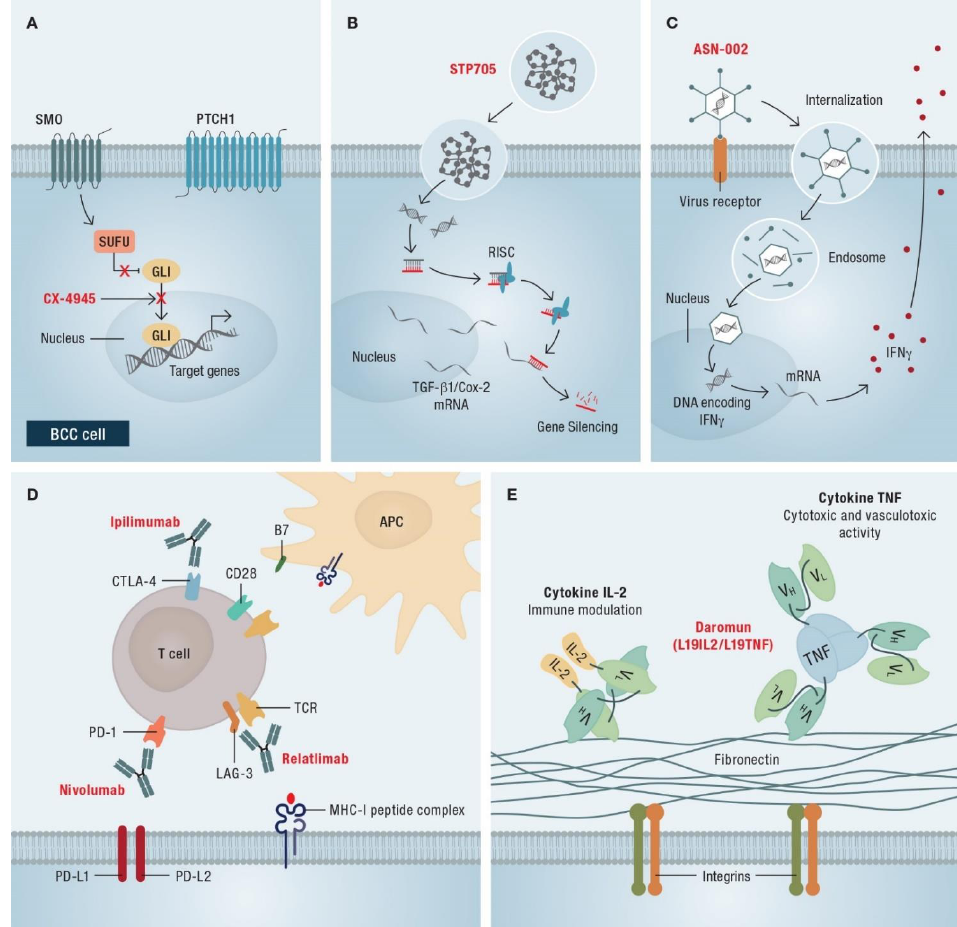
Figure 5. Schematic representation of the modes of action of novel drugs for basal cell carcinoma (BCC) therapy. ( A ) Loss-of-function mutations in PTCH1 or activating mutations in SMO activate the HH signaling pathway in BCC cells. CX-4945 acts on the terminal HH signaling components by inhibiting casein kinase CK2. Thus, the signal transduction pathway is interrupted; ( B ) STP705 consists of two small interfering RNA (siRNA) oligonucleotides packaged with a histidine-lysine (HK) polymer as a delivery system. The siRNA intermediates bind to an RNA-induced silencing complex (RISC), and then selectively degrade the complementary single-stranded target RNA. As the siRNA of STP705 targets the mRNA of transforming growth factor (TGF)- β 1 and cyclooxygenase (Cox)-2, respectively, it downregulates the expression of TGF- β 1 and COX-2, resulting in tumor growth inhibition; ( C ) ASN-002 functions as a recombinant adenovirus vector, delivering the human interferon (IFN)- γ gene into BCC cells. IFN- γ secretion results in a local IFN- γ concentration within the tumor; ( D ) the checkpoint inhibitor nivolumab blocks binding of programmed cell death protein 1 (PD-1) on T cells to its ligands programmed cell death 1 ligand 1 (PD-L1) and PD-L2 on tumor cells. Relatlimab is an antibody directed against the inhibitory molecule lymphocyte-activation gene (LAG)- 3. Binding of cytotoxic T-lymphocyte-associated protein (CTLA)-4 to the B7 molecules as antagonist of CD28 on antigen-presenting cells (APCs) is blocked by ipilimumab. These checkpoint inhibitors may release the T cells from immunosuppressive mechanisms of the tumor microenvironment; ( E ) Daromun (L19IL2/L19TNF) consist of recombinant interleukin (IL)-2 and tumor necrosis factor (TNF)- α cytokines (respectively), fused to a human single-chain variable fragment directed against the extra-domain B (ED-B) of fibronectin (L19). After binding of the L19 moieties to the fibronectin on tumor cells, the cytokines can trigger an immune response against ED-B fibronectin-expressing tumor